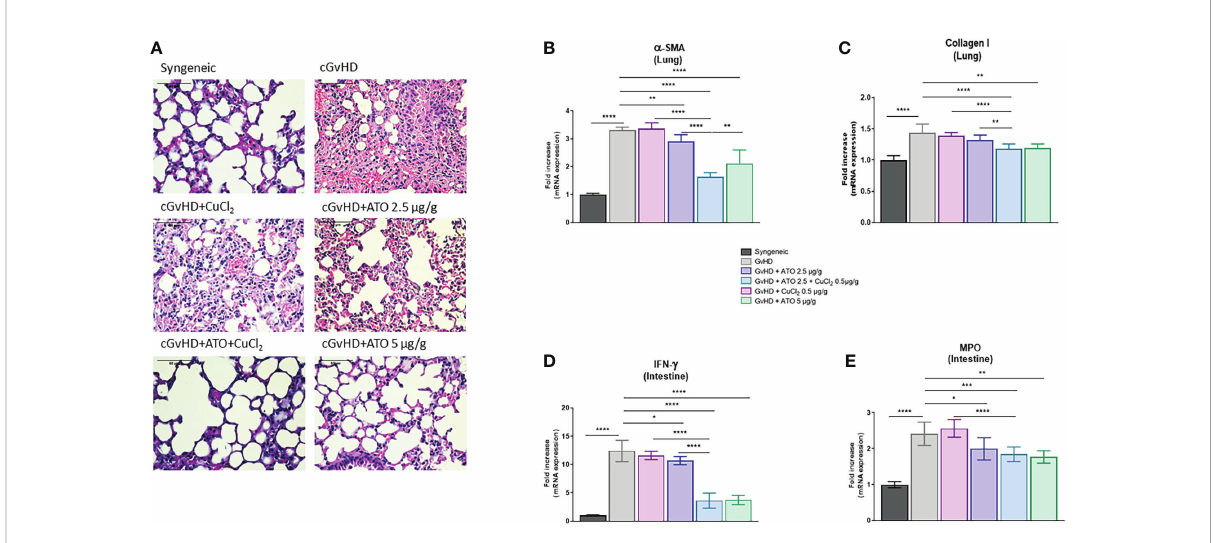
FIGURE 6 ATO and CuCl 2 reduce lung fi brosis and intestine in fl ammation. (A) Hematoxylin and eosin (H&E) staining of lung sections (5 m m) (Eclipse 80i microscope; Nikon, original magni fi cation ×20). Lung was disordered, with abundant in fi ltration of in fl ammatory cells and a reduction of intra- alveolar spaces (presentation of the 6 different groups of cGvHD mice). (B, C) Relative mRNA expression of a -SMA and collagen I in the lung. Data are presented as 2 ( − DD CT) relative to the levels of b -actin . (D, E) mRNA expression of IFN- g and MPO in the intestine, relative to the levels of b -actin . Data are presented as 2 ( − DD CT) . *p <0.05; **p<0.01; ***p<0.001; ****p<0.0001. The results for each group are the mean of the measurements obtained per mouse: syngeneic (n = 7); cGvHD (n = 10); cGvHD-Cu (n = 6); cGvHD-ATO 2.5 µg/g (n = 8); cGvHD-ATO-Cu (n = 11); cGvHD-ATO 5 µg/g (n = 5). Ex vivo measurements were realized in duplicate for each